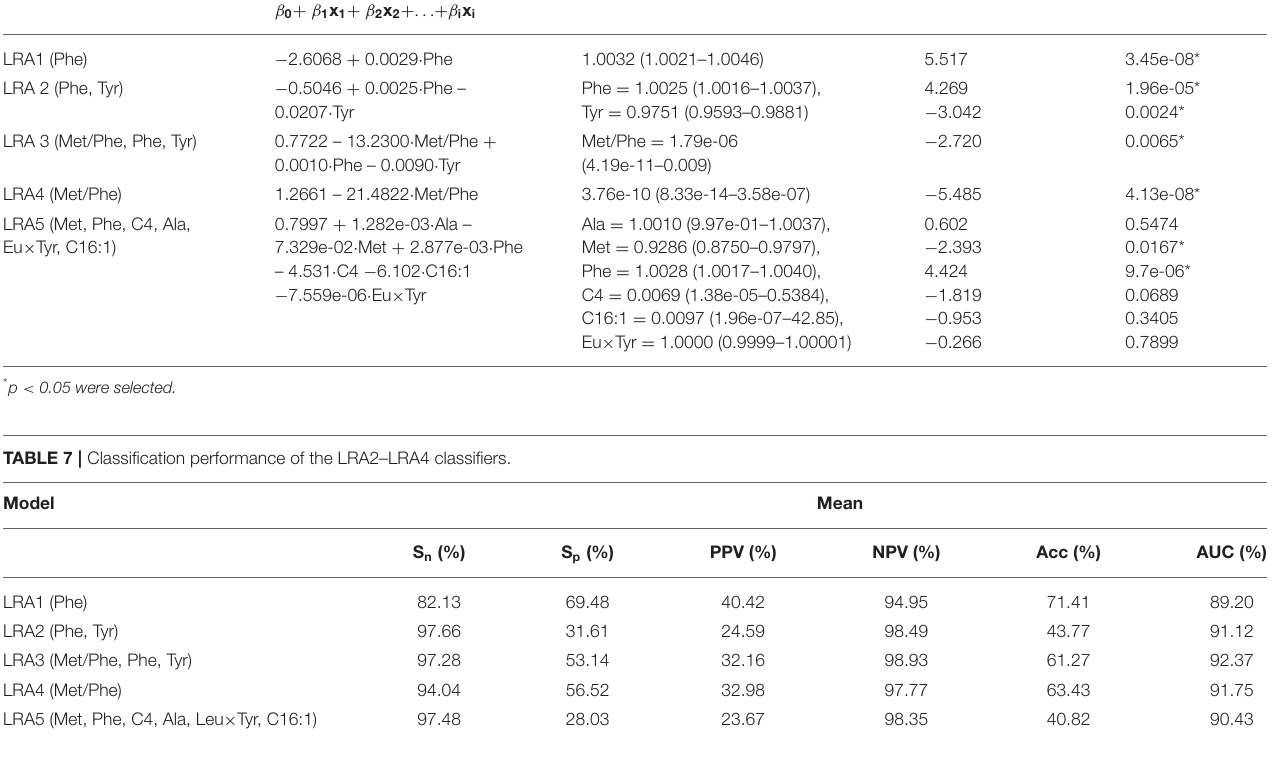
TABLE 6 | LRA1–LRA5 classification models. Model